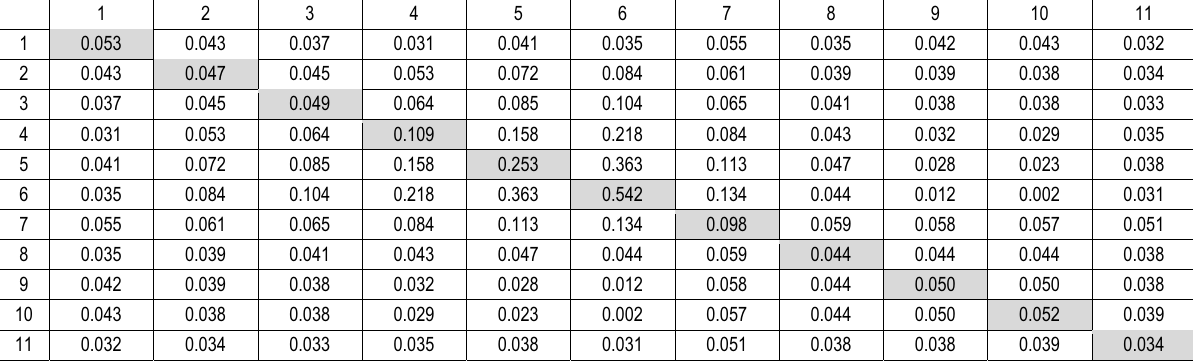
Table 5. Covariance matrix of insurance services portfolio